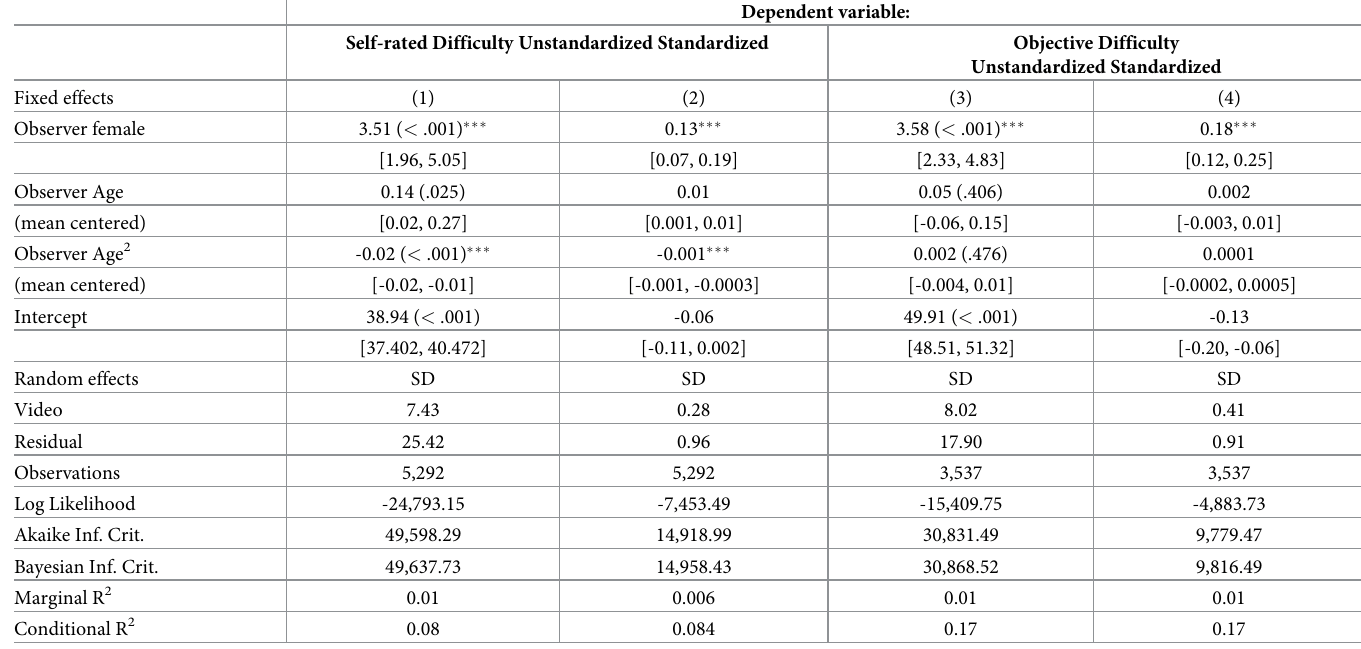
Table 2. Mixed effects models for self-rated difficulty and objective difficulty predicted by observer sex and age and a random effect for video. Exact p values are shown in the brackets next to the unstandardized estimates. 95% Confidence Intervals are shown in square